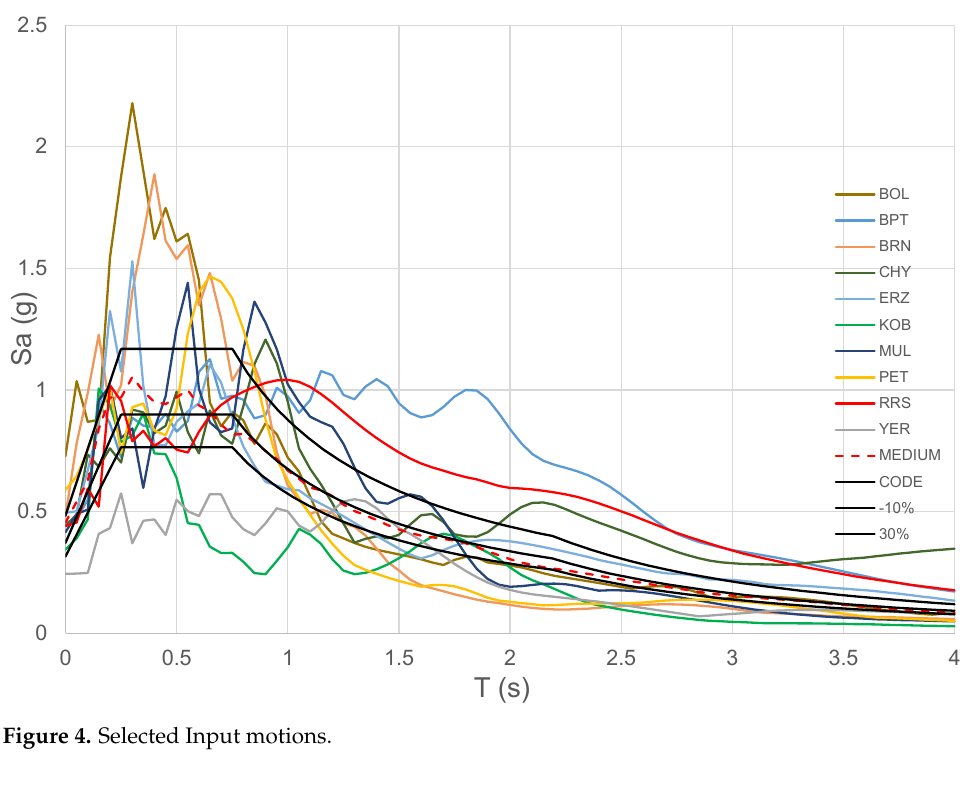
Table 5. Selected input motion